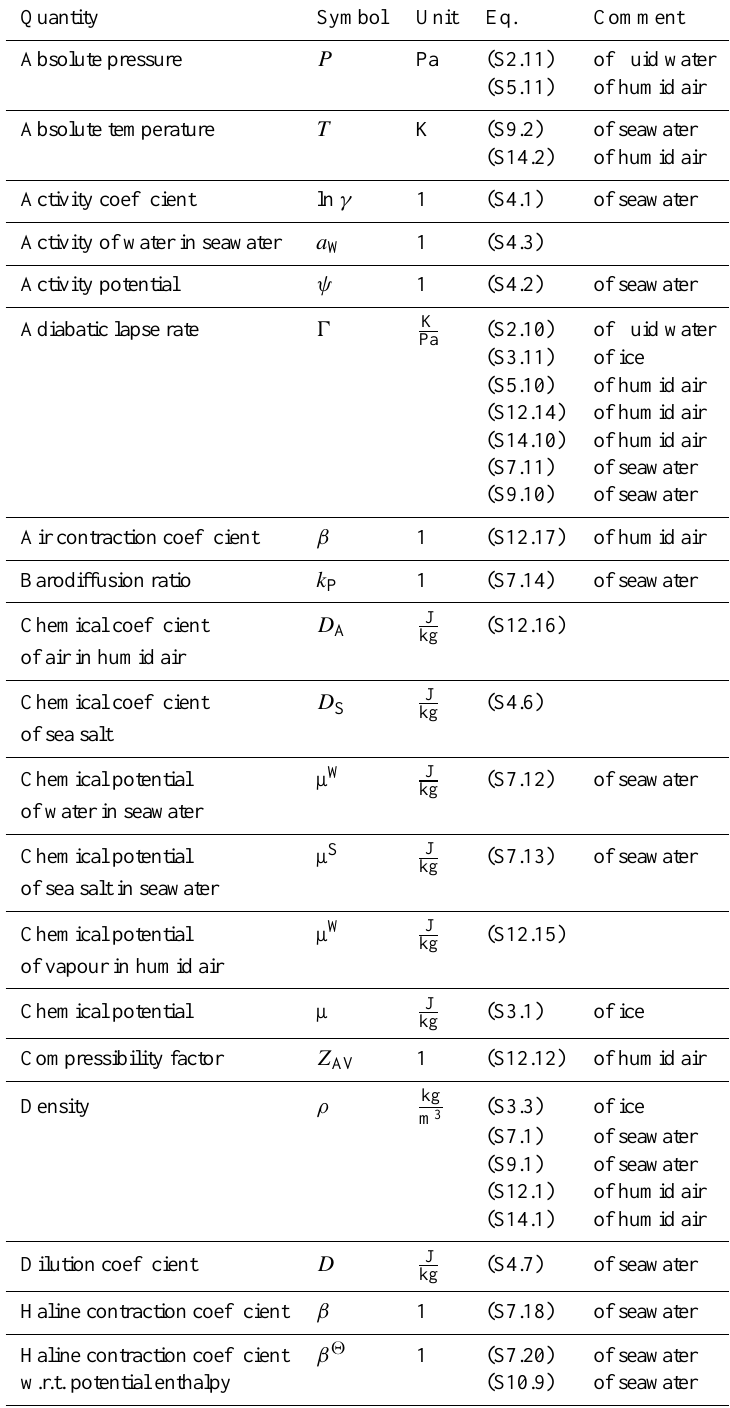
Table A12. Alphabetic index of single-phase